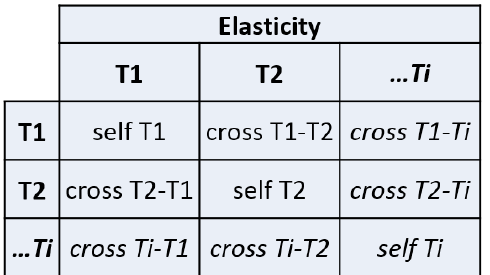
Figure 1. Example of elasticity matrix with self- and cross-elasticity